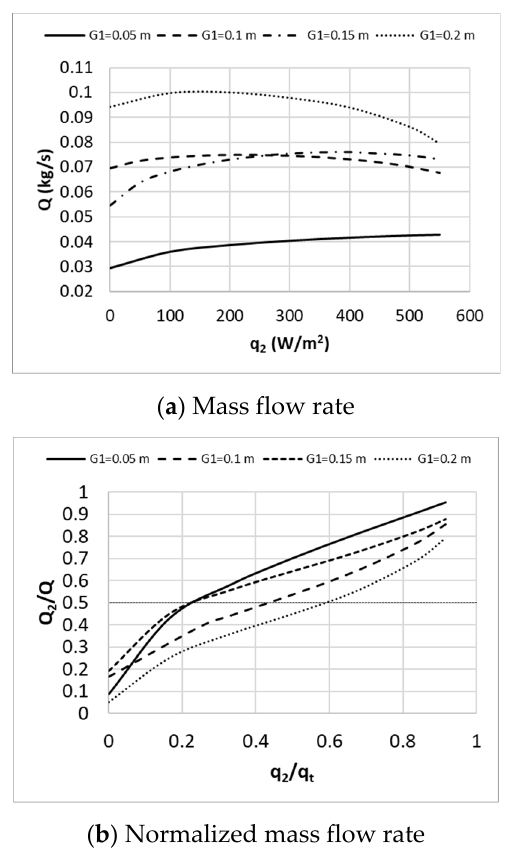
Figure 7. Mass flow rate of Configuration (III) ( 𝐺 (cid:2870) = 0.1 𝑚 ) at different values of 𝑞 (cid:2870) and 𝐺 (cid:2869) .